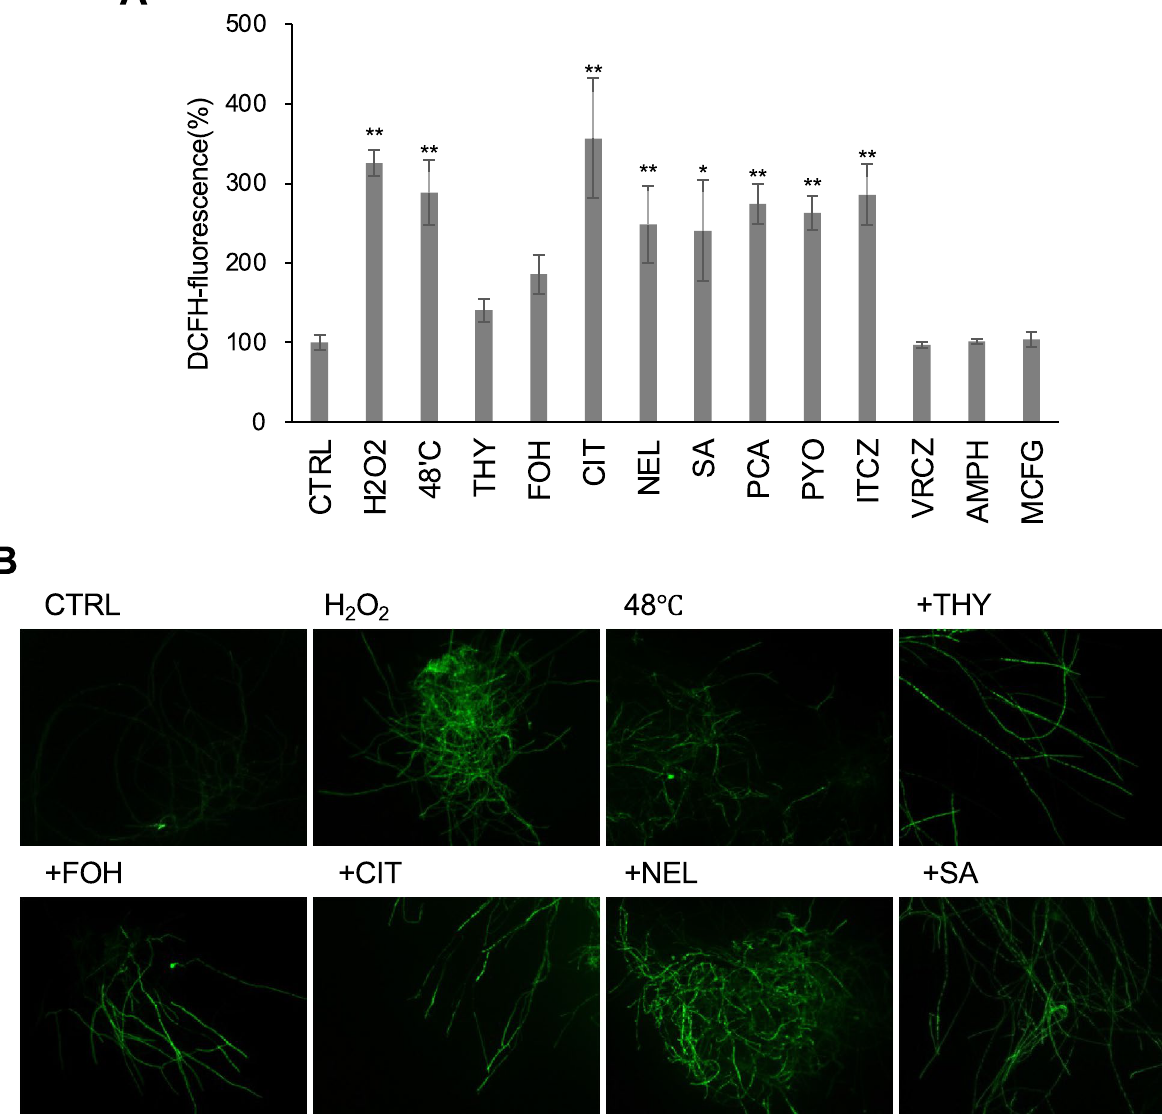
Figure 1. ROS production in A. fumigatus hyphae in response to antifungal treatments. ( A ) Intracellular ROS production, as indicated by DCFH-DA, was quantified. CTRL indicates the control sample without any stressors. The fluorescence intensity per protein amount of CTRL was defined as 100%. The cells were disrupted, and the extracts were used for fluorescence intensity measurement. The values were obtained from three replicates, and the error bar represents the standard deviation. H2O2: 10 mM hydrogen peroxide, THY: 1 mM thymol, FOH: 1 mM farnesol, CIT: 1 mM citral, NEL: 1 mM nerol, SA: 1 mM salicylic acid, PCA: 1 mM phenazine-1-carboxylicacid, PYO: 1 mM pyocyanin, ITCZ: 10 µg/mL itraconazole, VCZ: 10 µg/mL voriconazole, AMPH: 10 µg/mL amphotericin B, and MCFG: 10 µg/mL micafungin. Significant differences compared with the CTRL sample were examined using Dunnett’s tests and are indicated as * p < 0.05; ** p < 0.01. ( B ) Intracellular ROS was visualised using DCFH-DA and a fluorescence microscope. The cells were treated in the same way for the fluorescence intensity